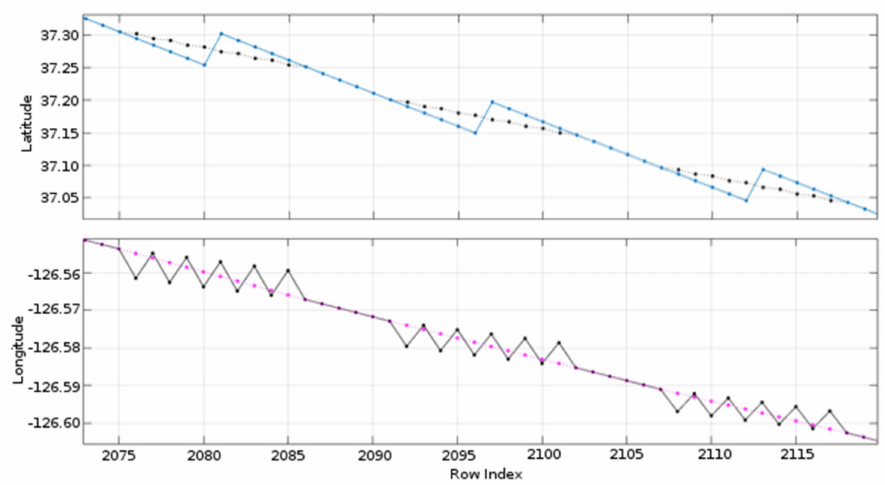
Figure 10. Top : Latitude values for the middle column of the grid portion shown in Figure 9. Blue line represents original latitude values and black line corresponds to latitudes reordered according to Figure 5c. Bottom : Longitude values for the same column. Black line corresponds to longitudes reordered according to Figure 5c. Zigzagging effect caused by Earth rotation is present at the bow-tie regions after reordering. Magenta line, representing adjusted longitudes, is monotonic. The adjustments are performed only at the overlapping portions of the consecutive